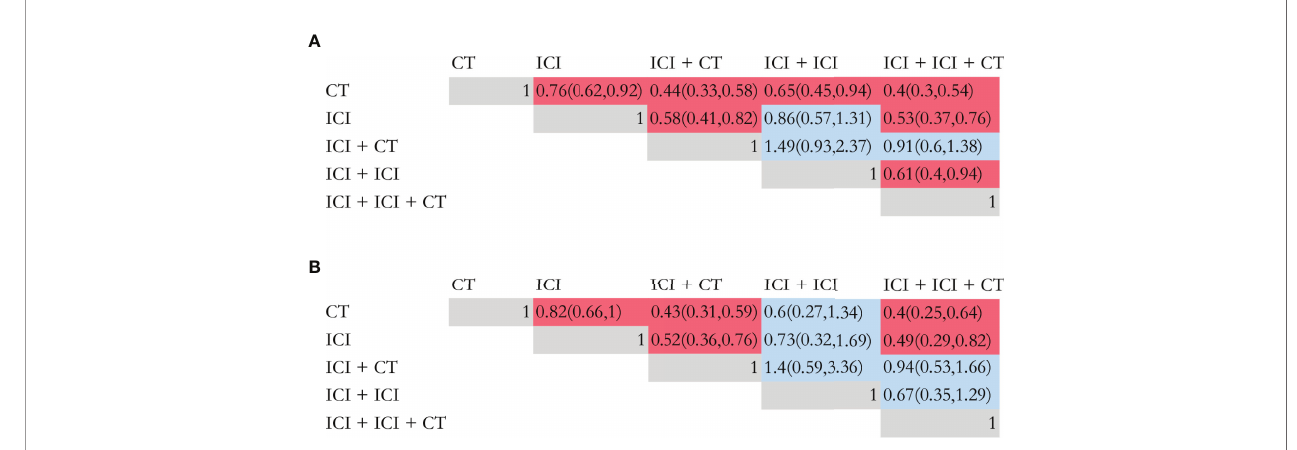
FIGURE 3 | Ef fi cacy of different immune checkpoint inhibitor regimens pro fi les based on overall survival (A) and progression-free survival (B) . Each cell of the ef fi cacy pro fi les contains the pooled hazard ratio and 95% con fi dence intervals; signi fi cant results are in red, otherwise, in blue. The pooled hazard ratio and 95% con fi dence intervals indicate the results of the column name compared with the row name. ICI, immune checkpoint inhibitor; CT,